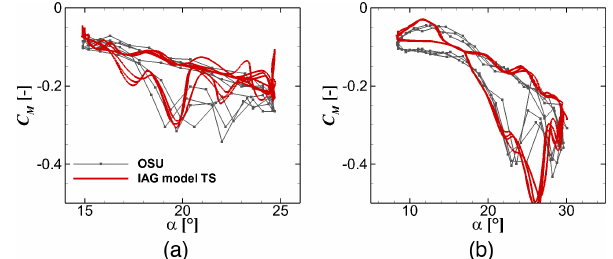
Figure 22. Pitching moment reconstruction by the IAG model in comparison with the measurement data (Ramsay et al., 1996) for (cid:49)t = T/ 1440 using the actual angle of attack in the experimen- tal campaign at various (cid:49)α values. (a) (cid:49)α = 5 . 5 ◦ ; (b) (cid:49)α = 10 ◦ . S801 airfoil, k = 0 . 073 and α = 20 ◦ .